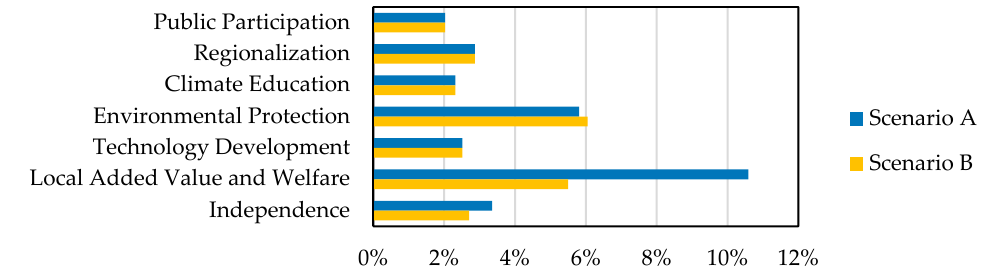
→ → x A and x B for Scenarios A and B. Figure 6. Unweighted degree of objective achievement 𝑥⃗ (cid:3002) and 𝑥⃗ (cid:3003) for Scenarios A and B.